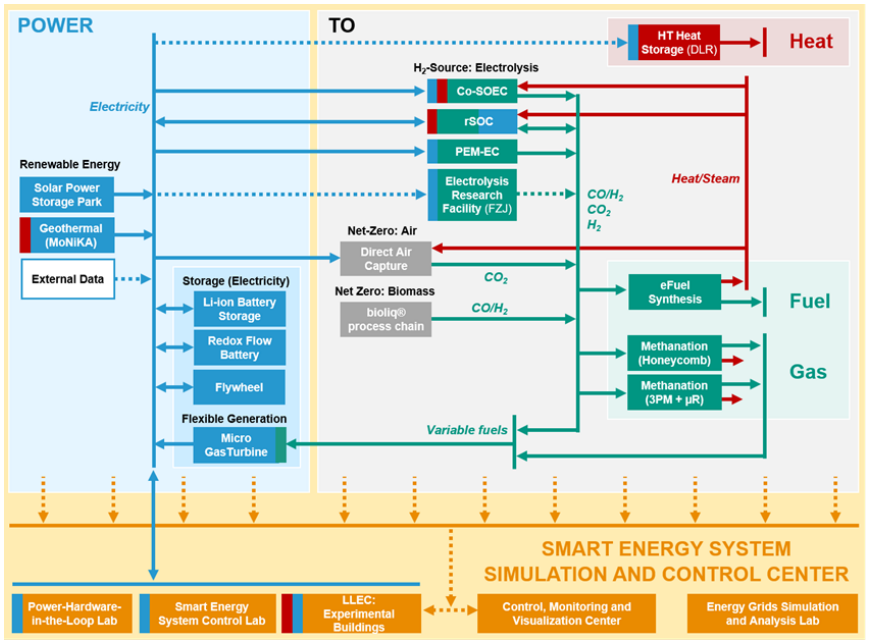
Figure 13. Interacting components: power generation, transformation, and storage in the Energy Lab 2.0 plant network (power-to-X) coupled with energy systems analysis on the theoretical and experimental levels in the Energy Lab 2.0 Smart Energy System Simulation and Control Center. Solid lines—physically-implemented coupling in the Energy Lab 2.0; dashed lines—data and model exchange; blue lines—electricity; green lines—chemicals; red lines—heat; yellow lines—data and models.